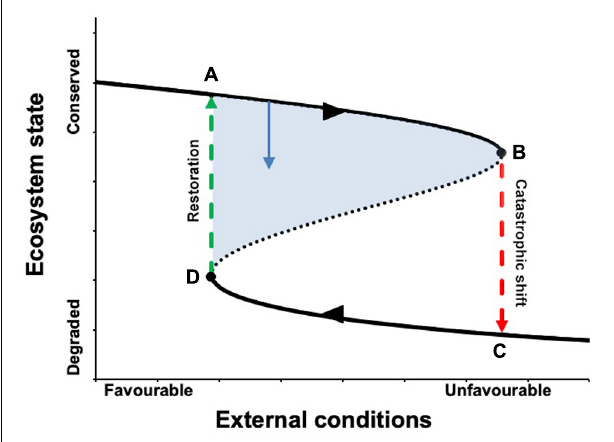
FIGURE 1 | The catastrophic shifts concept. The upper solid line following the arrow represents the gradual decline of the ecosystem as the external pressures become increasingly unfavorable (section A–B ). Point ‘ B ’ represents a point where the ecosystem cannot maintain a conserved ecosystem state and is undergoing a catastrophic shift to a degraded state (point ‘ C ’). The lower solid line following the arrow represents the gradual restoration of the already degraded ecosystem when the external conditions become more favorable (section C–D ). Point ‘ D ’ represents a point at which the ecosystem is restored to a conserved state (‘restoration’). The latter transition can almost only be achieved under active restoration. The blue area represents resilience, the blue arrow a disturbance, and the black dots tipping points. Degradation can occur anywhere in the figure, while restoration can occur from any point on the upward lower